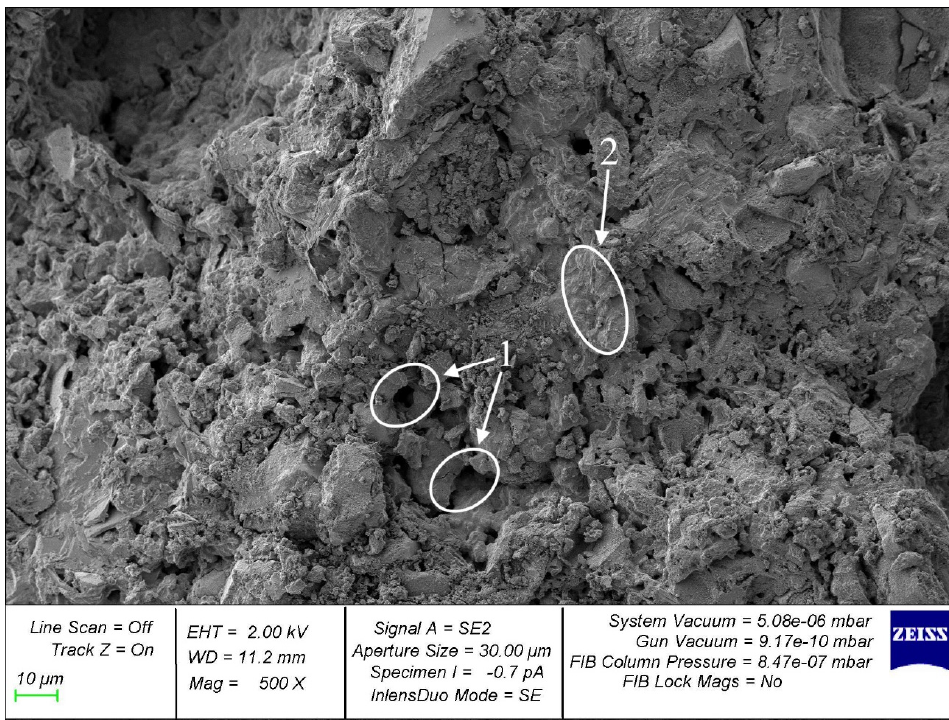
Appl. Sci. 2022 , 12 , x FOR PEER REVIEW Figure 15. Sample with 8% snail shell powder dosage (1—porosity, 2—binder phase).